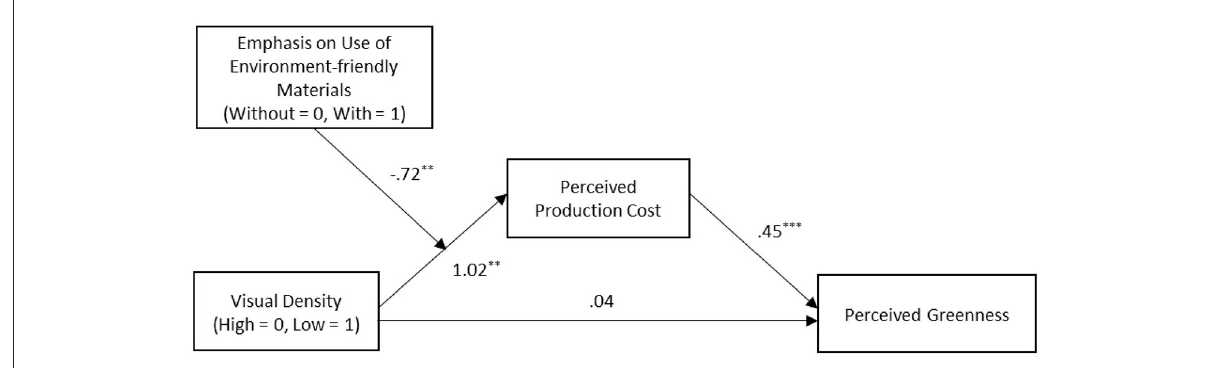
FIGURE4 The moderation effect of emphasizing the use of environment-friendly materials. * p < 0.1, ** p < 0.05, and *** p < 0.01. Unstandardized coefficients are